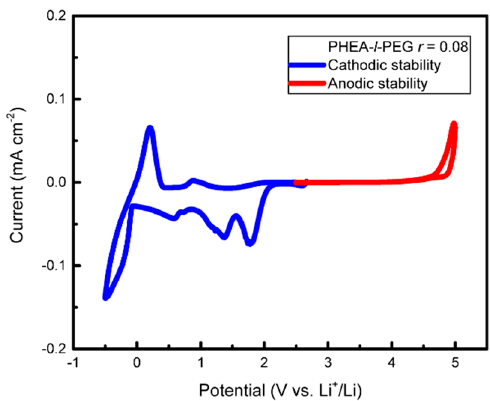
Figure 3. Cyclic voltammetry of SPE-1. The data show the plating and stripping of Li at approx. 0 V and stability up to 4.5 V. The peaks between 0.5 and 2 V show a mild cathodic instability of the system. The tests were performed at a scan rate of 0.2 mV s − 1 , 70 °C, r = 0.08, in a Li/SPE/stainless steel cell (anodic scan), and a Li/SPE/Cu cell (cathodic scan). HEA monomer substitution with the IBA monomer, resulting in PHEA- co -IBA- l -PEG (SPE-2), was investigated to explore the possibility of modifying the mechanical properties of SPE-1. Adding the IBA monomer did increase the storage modulus relative to SPE-1 at similar LiTFSI concentrations, but there was a drop in ionic conductivity upon electrolyte stiffening (Figure 4a,b).